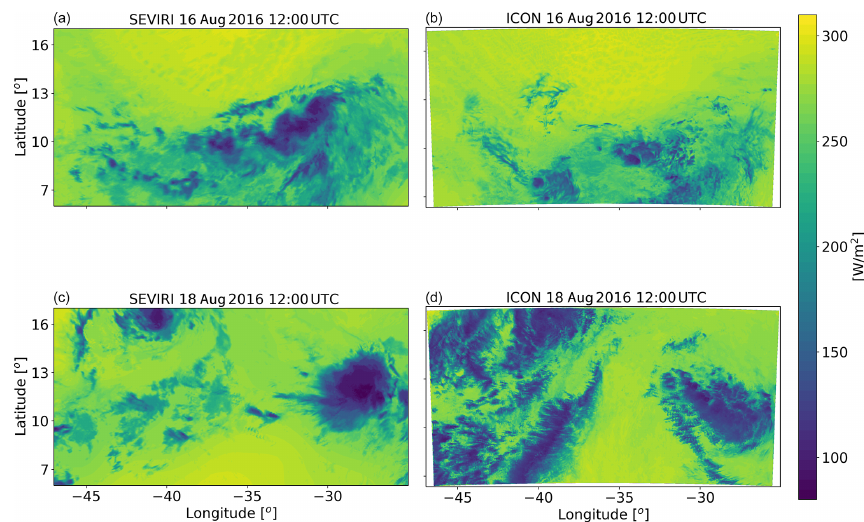
Figure 3. Similar to Fig. 2 but for the deep-cloud-dominated case (16–18 August 2016).